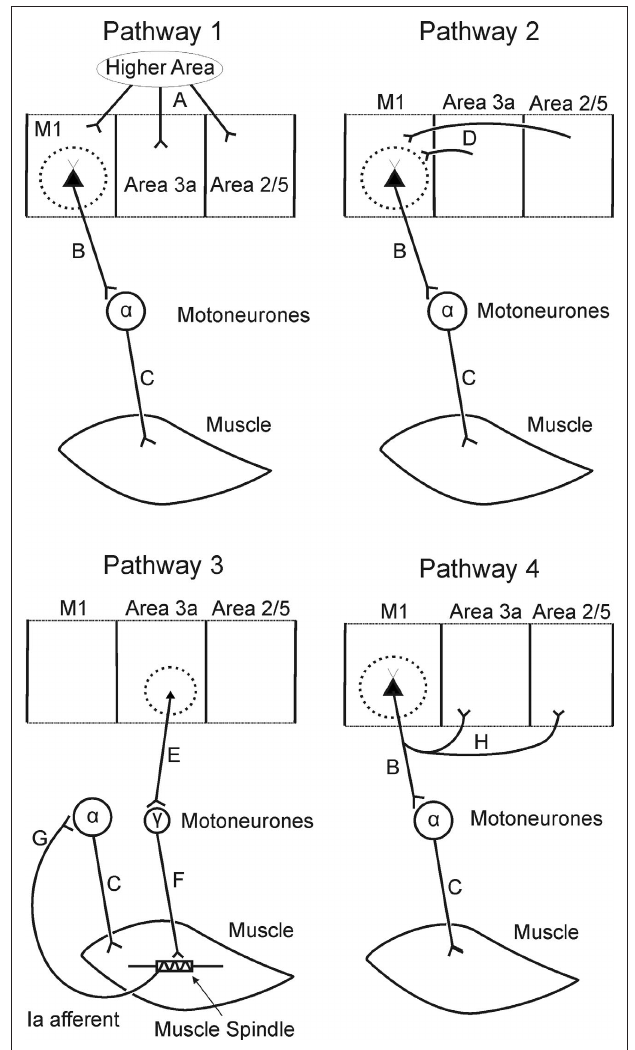
Figure 7 | Schematic showing possible pathways underlying coherence between S1/area 5 and eMg. Lettered labels are referred to in